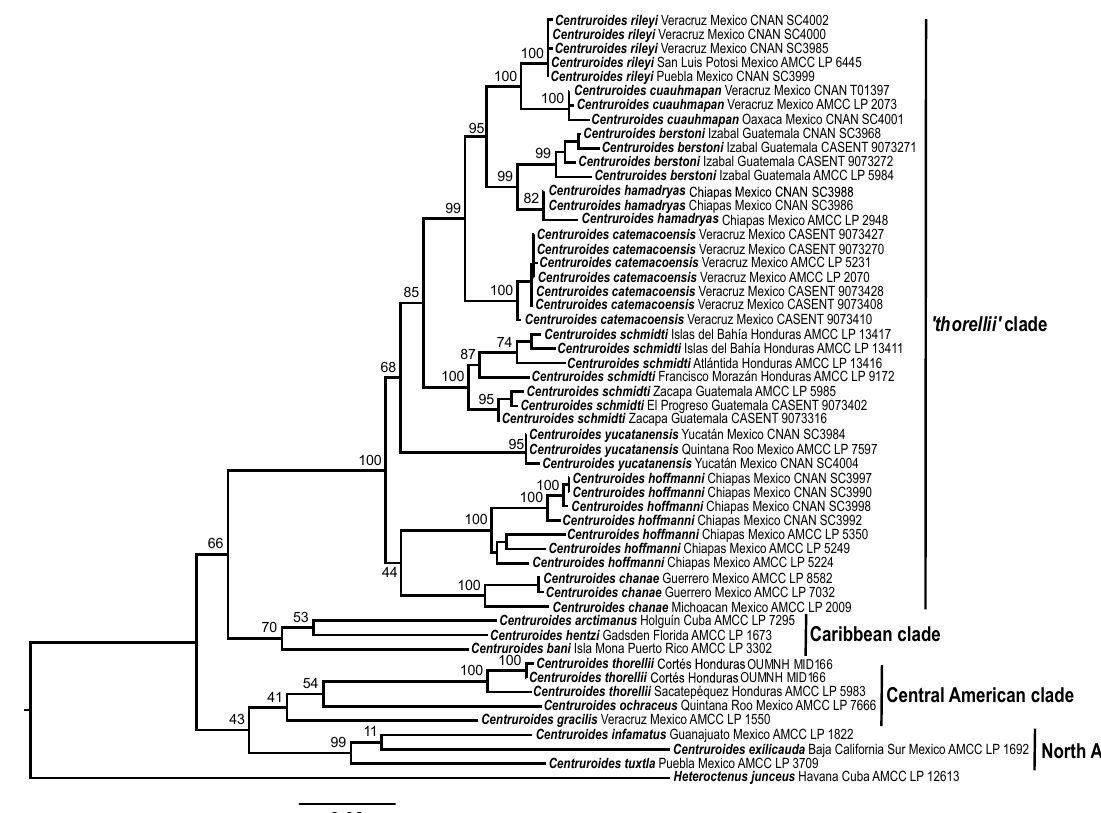
Figure 2. Phylogeny of the arboreal Neotropical ‘ thorellii ’ clade of Centruroides Marx, 1890 bark scorpions (Buthidae C.L. Koch 1837) based on maximum likelihood analysis of 112 morphological characters and 1078 base pairs of DNA sequence from the mitochondrial Cytochrome c Oxidase Subunit I gene for 53 specimens of the ingroup with outgroup species of Centruroides and Heteroctenus junceus (Herbst, 1800). Material was deposited in the following collections: Ambrose Monell Cryo Collection (AMCC) at the American Museum of Natural History, New York; Colección Nacional de Arácnidos, In-